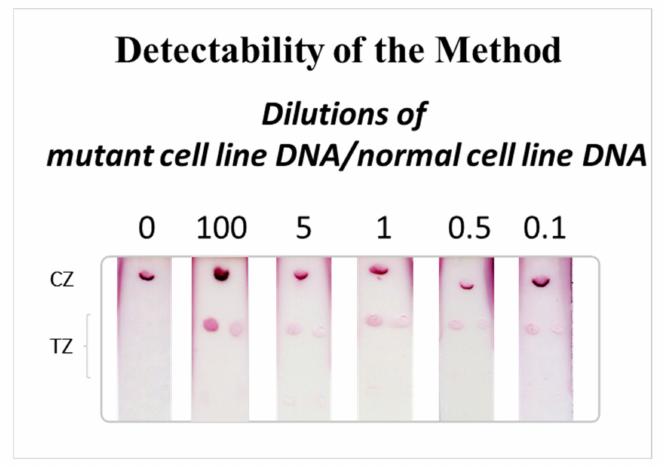
Figure 4. Detectability of the method. Different dilutions of mutant cancer cell line DNA/normal cell line DNA (0.1–100%) were prepared and analyzed by the multiplex strip test after amplification with subsequent multiplex PEXT reaction. TZ: test zone, CZ: control